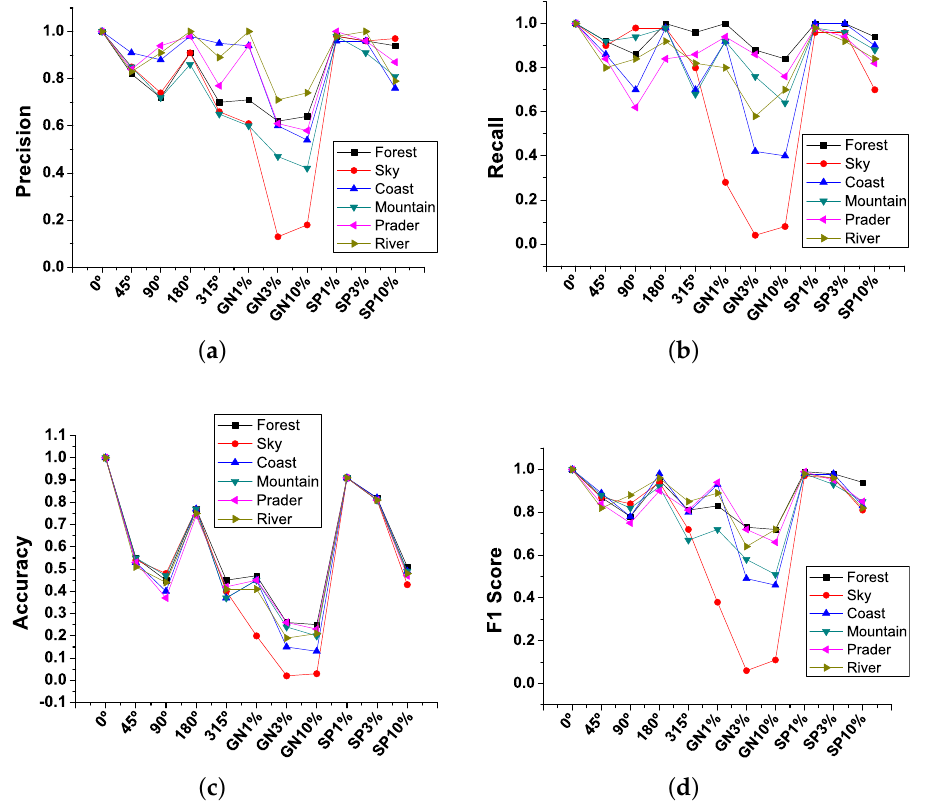
Figure 18. Technical efficiency measures for the best GA individuals for each scenery: ( a ) precision measure, ( b ) recall measure, ( c ) accuracy measure and ( d ) F1 score